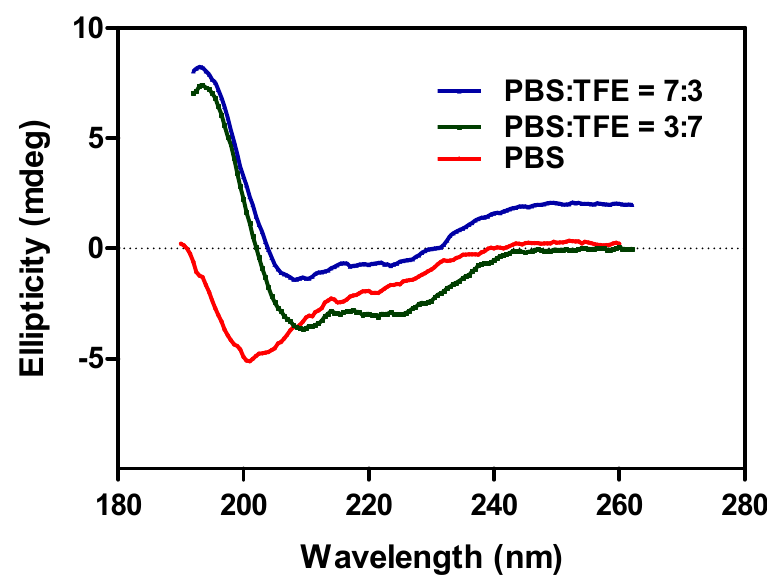
Figure 3. The circular dichroism (CD) spectrum of the PPT 233–245+G segment in different solvent systems.